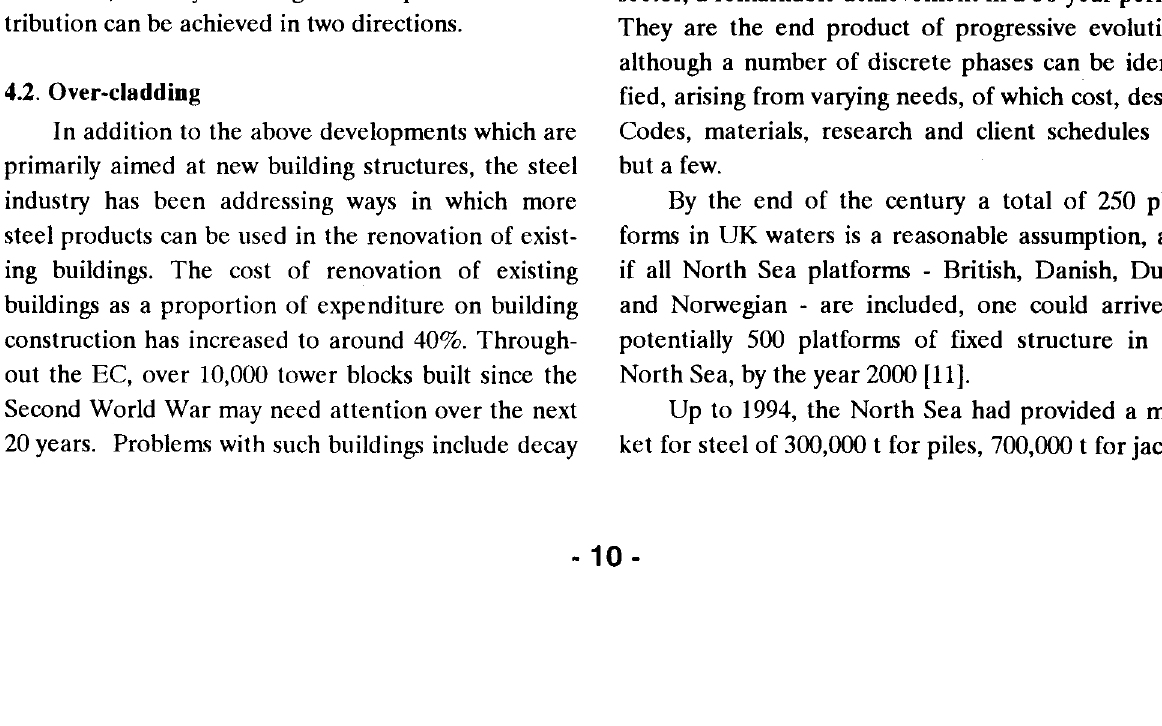
Fig 10. Celllar beam used in composite floor Haunched beams: Haunching can be used to transfer moment to the column, thus reducing beam depth by about 30%, allowing ducts to pass below the beam'>.